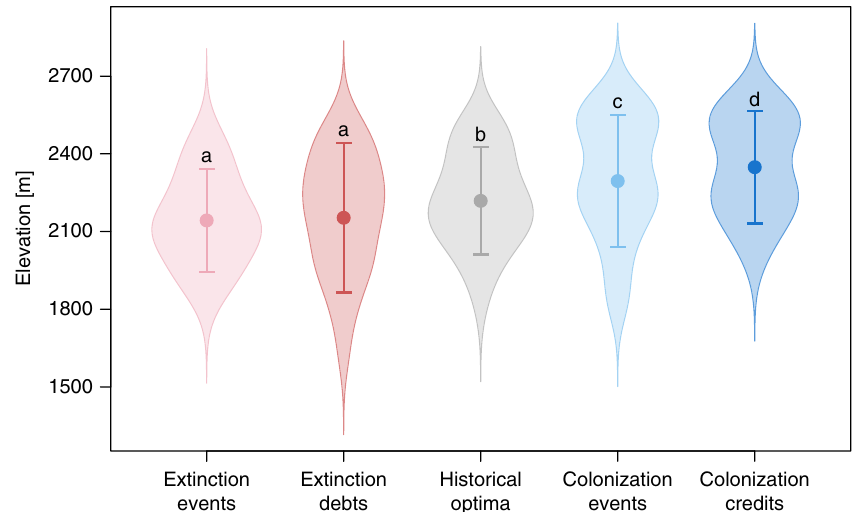
Fig. 2 Elevational distribution of realized and unrealized extinction and colonization events. For each species, we calculated the median elevation of all plots where a species was observed historically (historical optima; gray; n = 135 species), where extinction events (light red; n = 135 species) and colonization events (light blue; n = 133 species) were observed, and where extinction debts (red; n = 128 species) and colonization credits (blue; n = 134 species) were detected. Density distributions of these median elevations per species are depicted as shaded polygons with outliers removed to improve clarity and the averages with standard deviations across all species as dots and whiskers, respectively. Letters above error bars denote signi fi cant differences in elevational positions between the fi ve groups based on paired t-tests with Bonferroni correction. Source data are provided as a Source Data fi